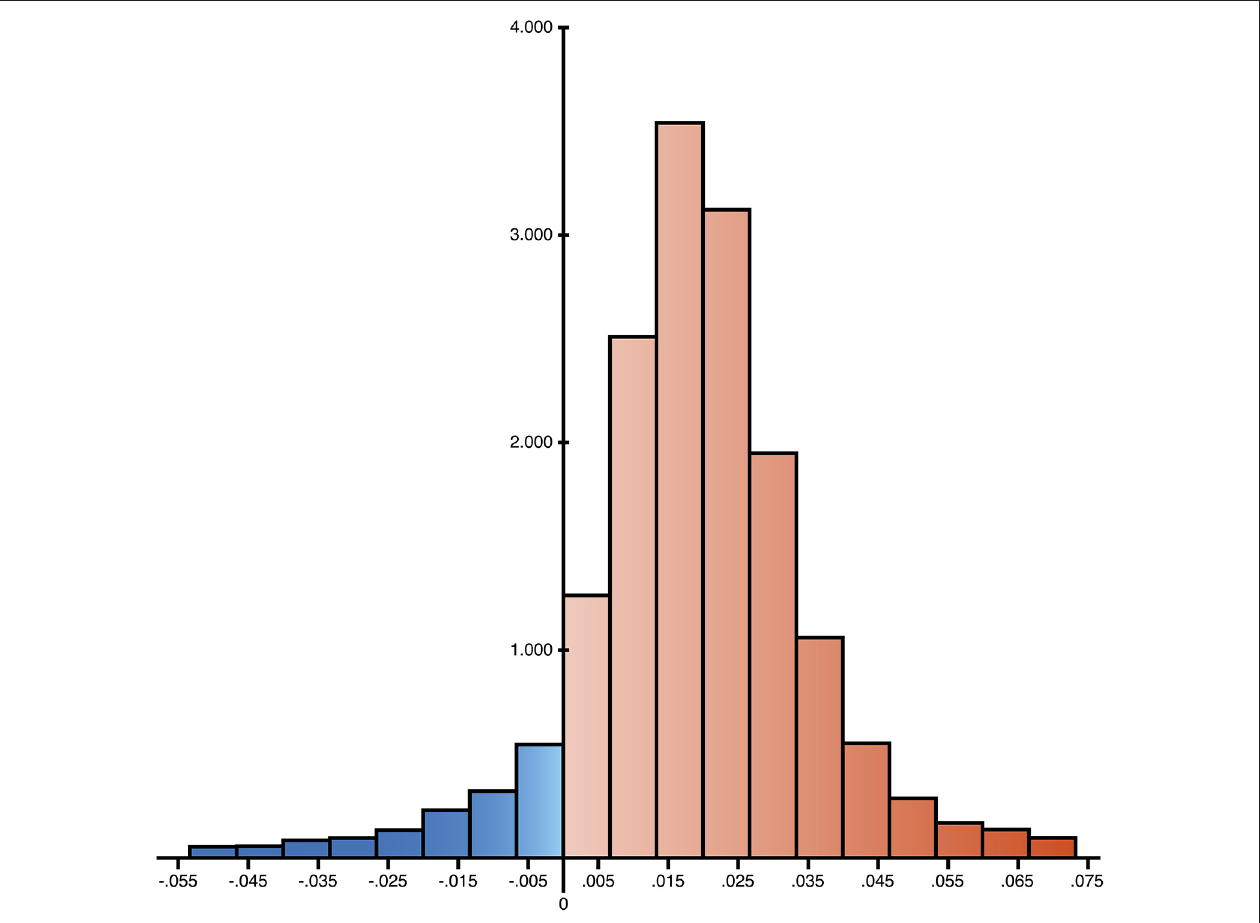
FIGURE 2 | Distribution of the differences of ratio of expected allele (REA) values between controls and AD group. 16,544 nps have been analyzed and the differences resulted positive for 14,847 cases, reported in red in the histogram (89.7%), suggesting a widespread increase of allelic shift in AD